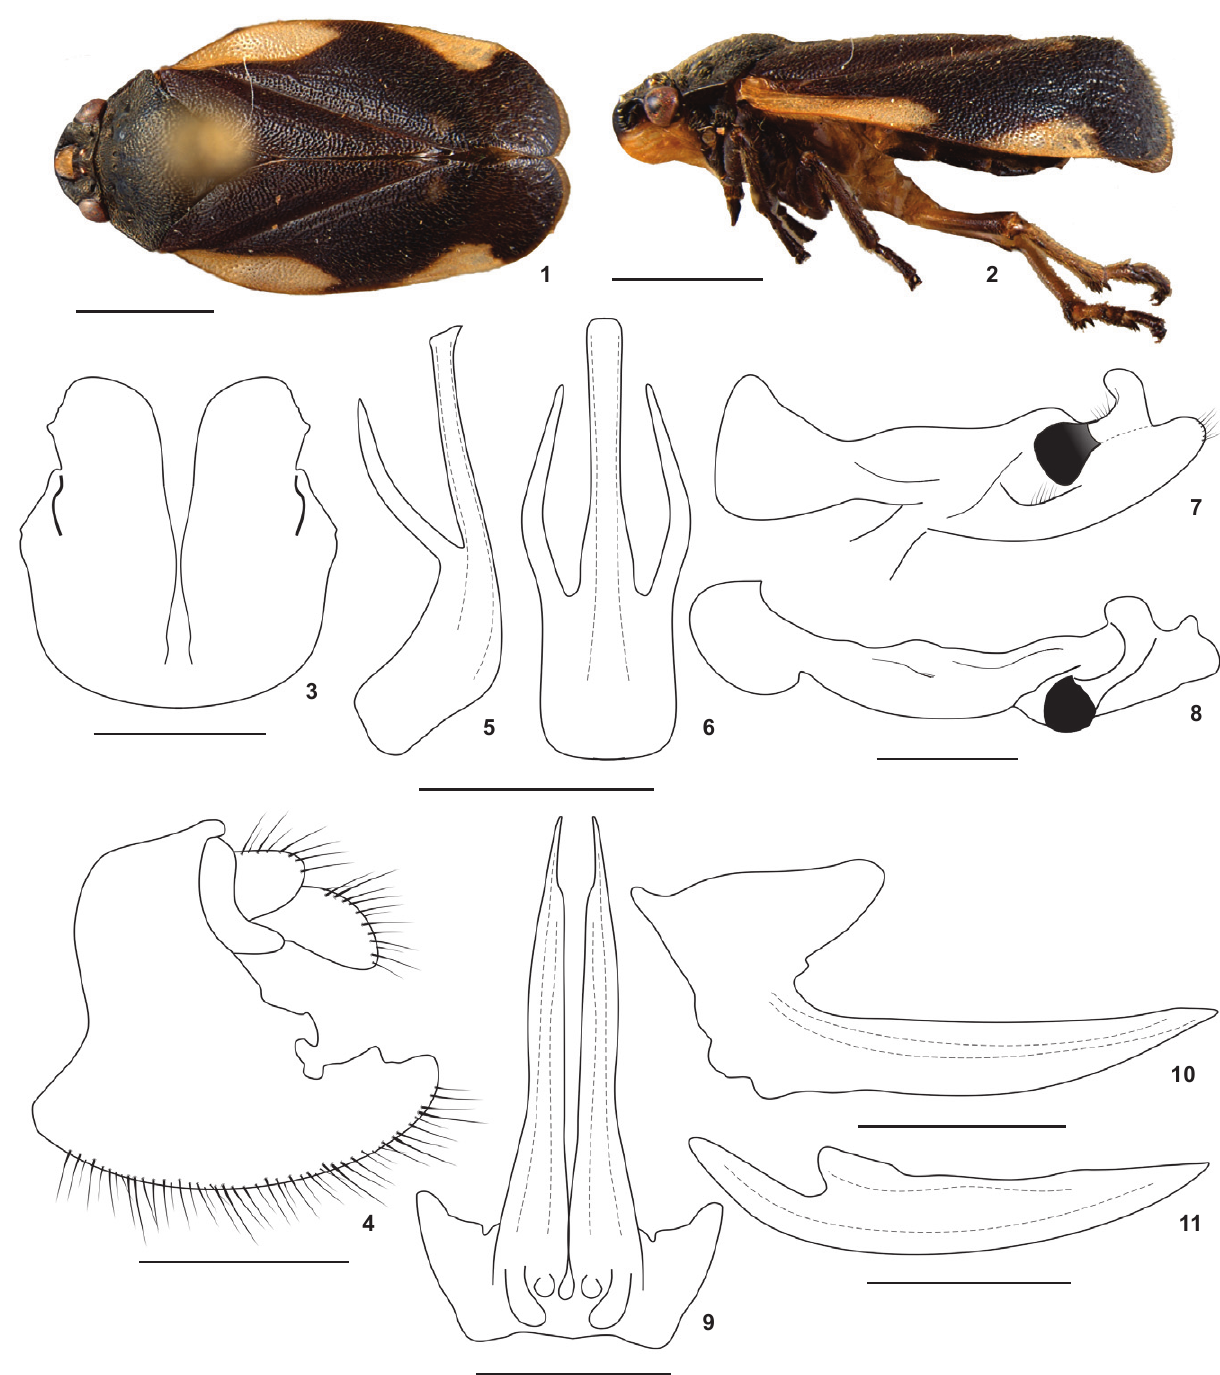
Figures 1-11. Gervasiella oakenshieldi sp. nov. : (1-2, 9-11) female paratype, (3-8) male holotype: (1) habitus, dorsal view; (2) habitus, lateral view; (3) subgenital plates and pygofer, ventral view; (4) pygofer and subgenital plates, lateral view; (5) aedeagus, lateral view; (6) aedeagus, dorsal view; (7) paramere, lateral view; (8) paramere, dorsal view; (9) first valvulae of ovipositor, ventral view; (10) first valvulae of ovipositor, lateral view; (11) second valvulae of ovipositor, lateral view. Scale bars: 1-2 = 2 mm, 3, 4, 9-11 = 0.5 mm, 5-8 = 0.25